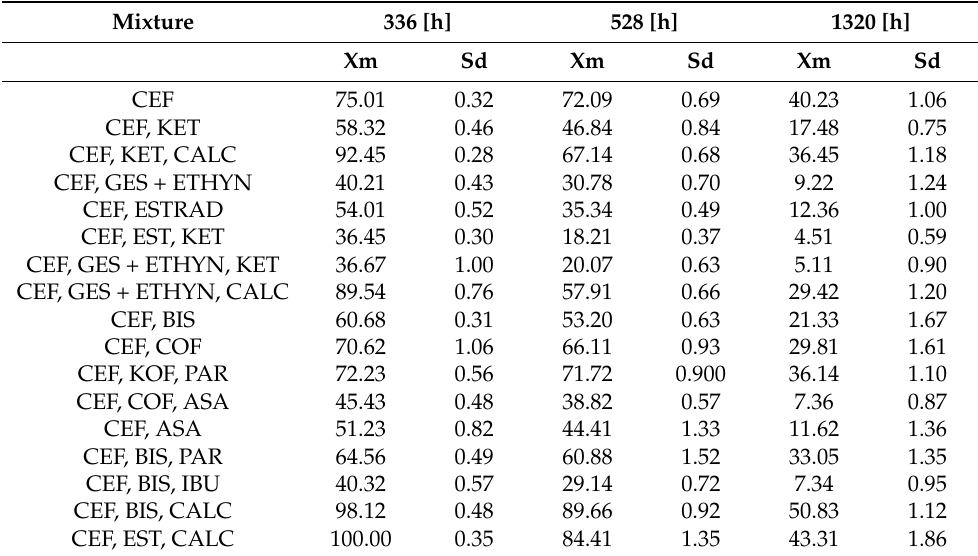
Table 1. Concentration [%] changes of cefepime in various drug mixtures during incubation at 4 ◦ C ( n =